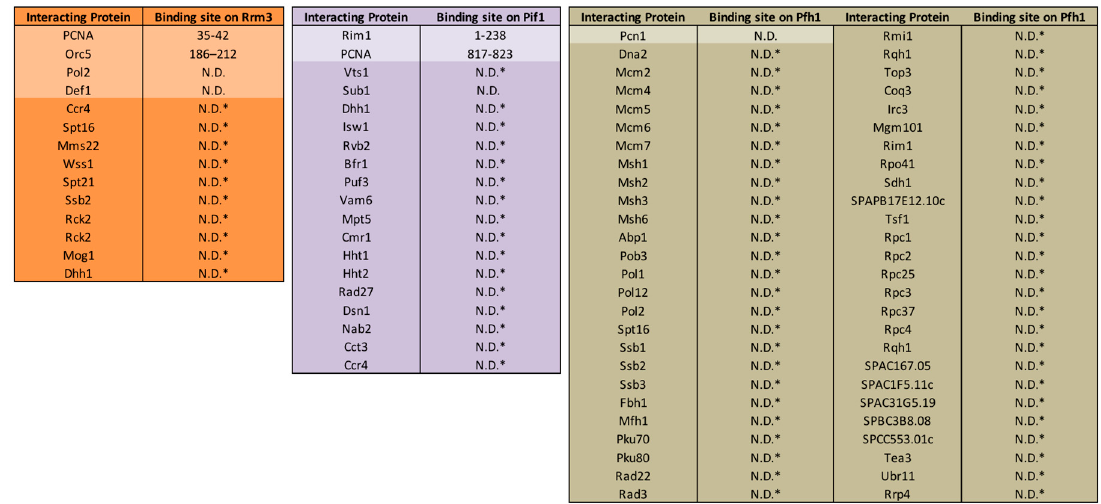
Figure 4. Physical interactions of Rrm3, ScPif1, and Pfh1. Interactions of Rrm3, ScPif1, and Pfh1 with proteins in lighter colored boxes have been verified by yeast-two-hybrid and / or co-immunoprecipitation. Binding sites on Rrm3, ScPif1, and Pfh1 and the method of detection are indicated. Putative binding proteins shown in darker colored boxes were identified in various high-throughput a ffi nity capture experiments [9,11,19,40,42,52,93,106–130].